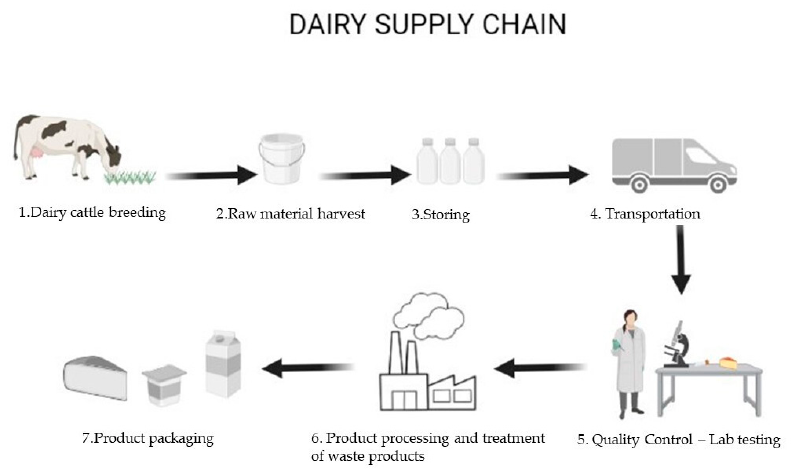
Figure 2. Dairy process flow diagram.